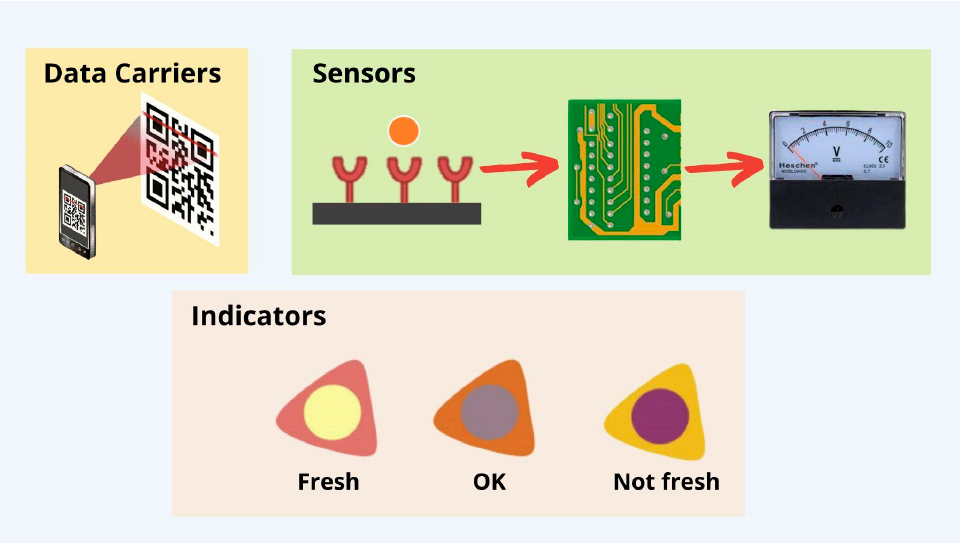
Figure 6. Typical intelligent packaging for food products.